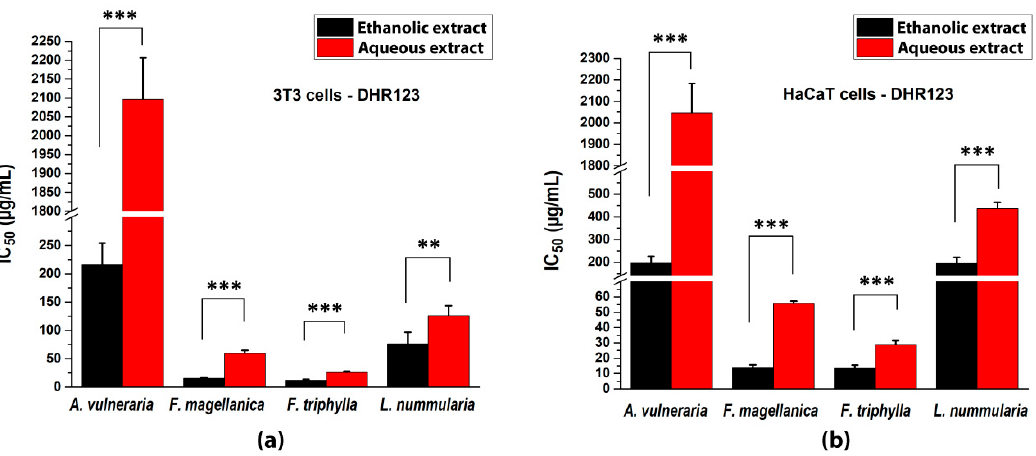
Figure 4. Intracellular antioxidant capacities of studied plant extracts with DHR123 ( a ) on 3T3 fibroblast cells and ( b ) on HaCaT cell culture. 50% inhibitory concentrations were calculated from the equations obtained for the inhibitory capacities of the serial dilutions of the extracts. Mean ± SD of 5 independent experiments, n = 5 × 4 replicates for each concentration. The aqueous and ethanolic extracts were compared with t-probe (** p < 0.01, *** p < 0.001).